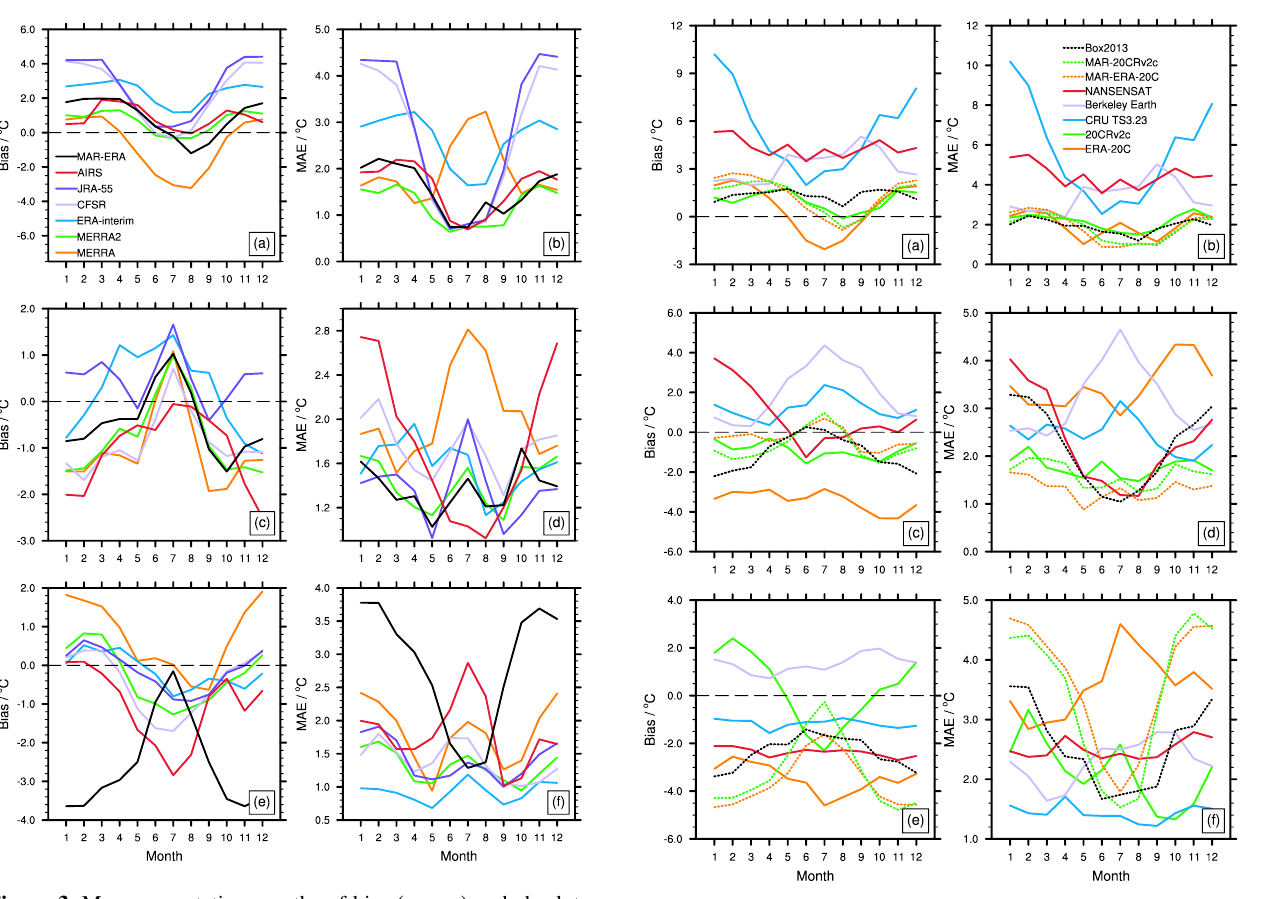
Figure 4. As in Fig. 3, but for elevation-corrected long reanalyses, MAR–ERA–20C and MAR–20CRv2C, Box2013 data and three gridded SAT analyses (not elevation